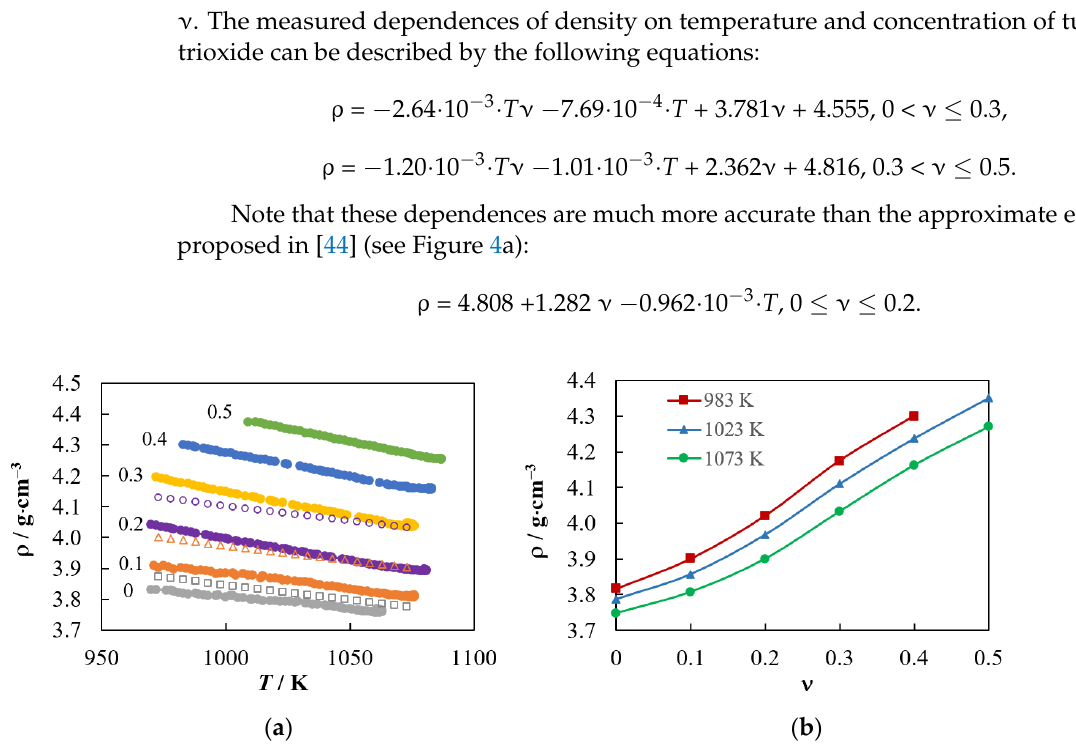
Figure 4. ( a ) Experimental temperature dependences of the density of the (1– ν )Na 2 WO 4 – ν WO 3 melts. The WO 3 mole fraction values ( ν ) are shown in the figure. Our results are compared with the calculation by Equation (12) [44] at a ν equal to 0 ( □ ), 0.1( △ ) and 0.2( ○ ). ( b ) Dependences of density on the WO 3 mole fraction at 983, 1023 and 1073 K.